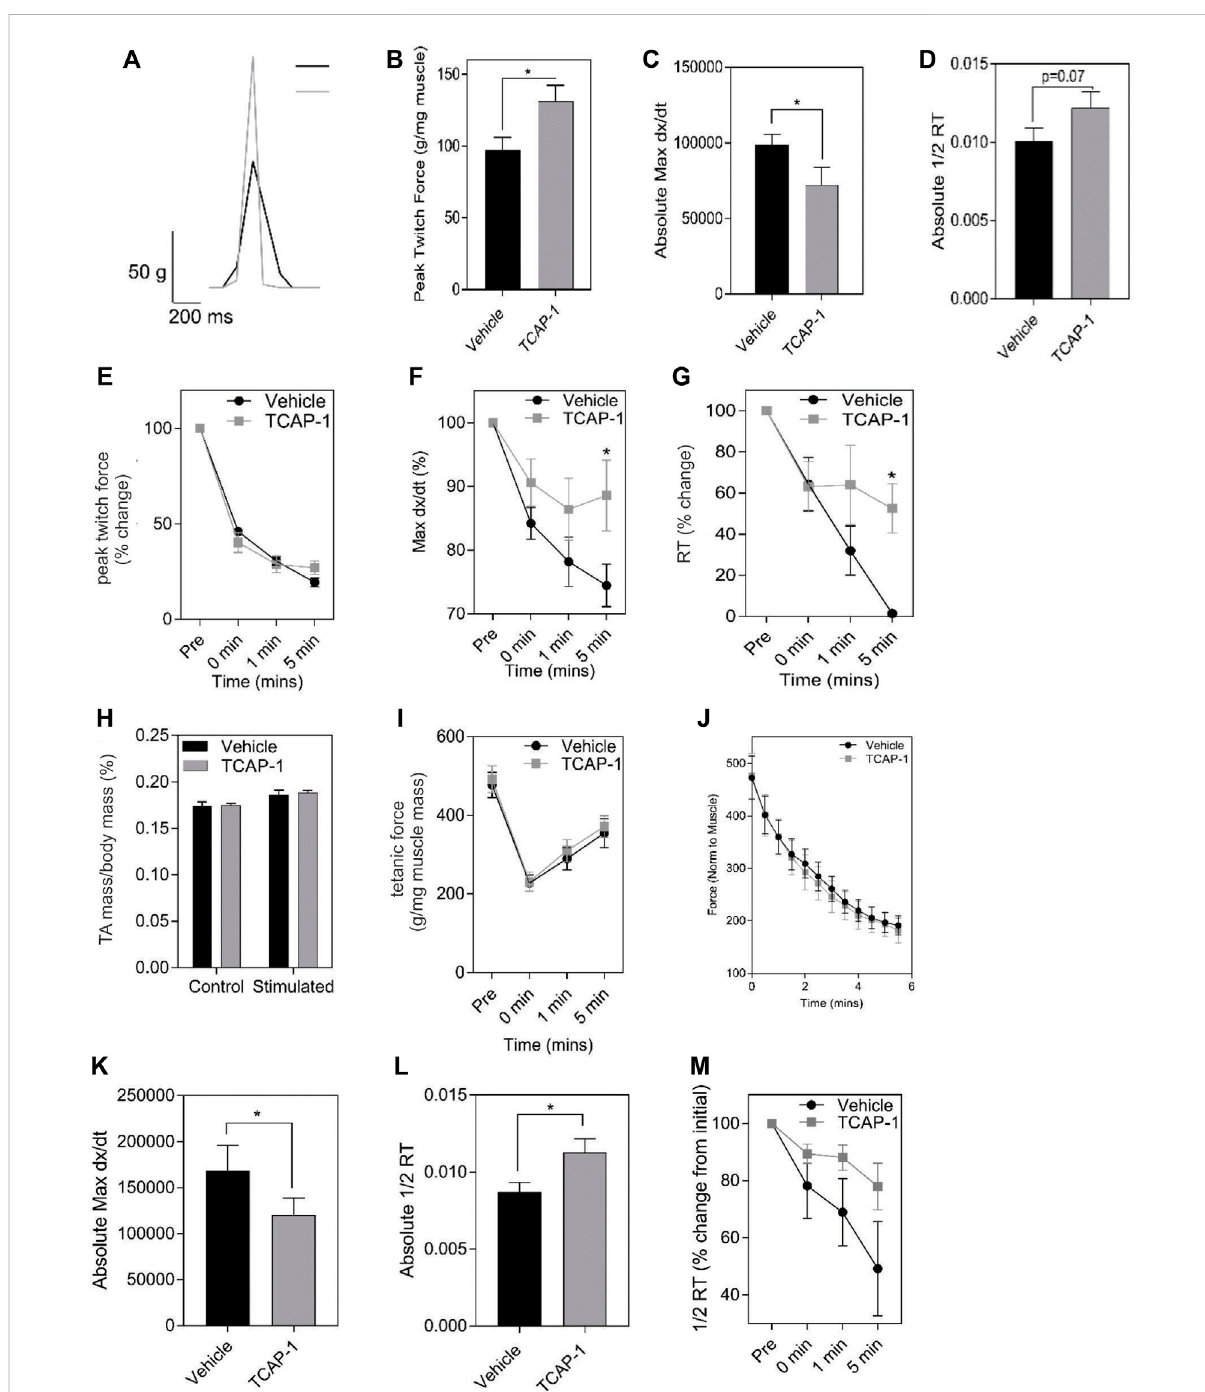
FIGURE 5 Invivo actionsofTCAP-1onratTAmusclekinetics. (A – J) .MuscletwitchkineticsafteranimalstreatedwithTCAP-1onceadayfor5 daysbefore testing (A) . Representative twitch traces (black, vehicle;gray, TCAP-1). (B) . Baseline contraction kinetics ( t -test). (C) . Contraction velocity ( t -test). (D) . Relaxation rate ( t -test). (E) . Peak twitch force (2-way ANOVA). (F) . Twitch max dx/dt (2-way ANOVA). (G) . 1/2RT analysis (2-way ANOVA). TCAP-1 treatmentdidnotaffectmuscleweight( t -test) (H) ,tetanicforce( t -test) (I) orfatigueforceovertime (J) ( n =7 – 8). (K – M) .Longtermtreatmentof TCAP-1 on rat hind-limb twitch kinetics. (K) . contraction max dx/dt. (L) . 1/2RT rate. ( M) . Relaxation